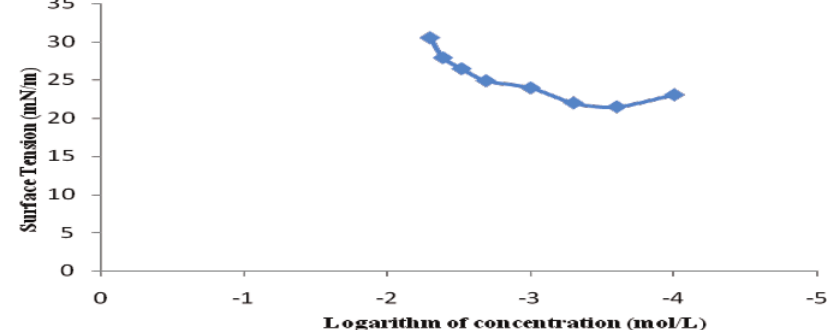
Figure 11. Change in surface tension of sodium phosphate-hydroxy ethanolamide with logarithm of